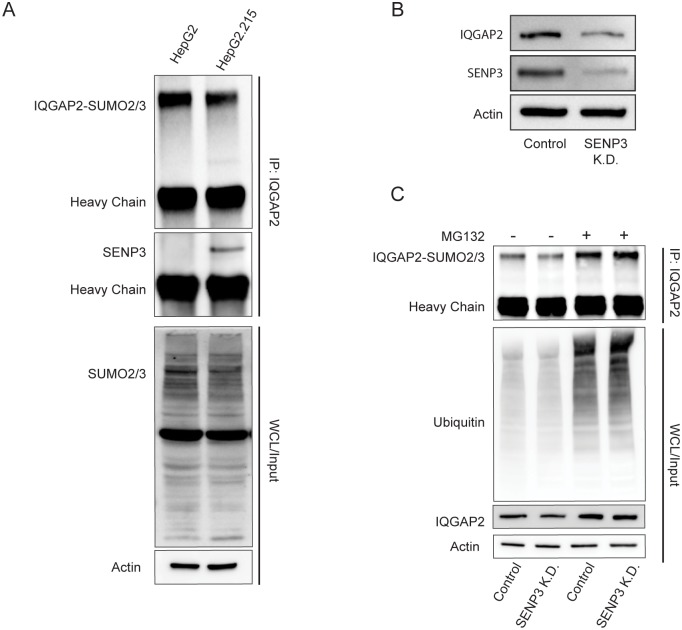
IQGAP2 is a de-SUMOylation target of SENP3.(A) Upper: immunoprecipitation (IP) with an anti-IQGAP2 antibody in HepG2 and HepG2.215 cells followed by immunoblotting of SUMO2/3 and SENP3; lower: immunoblotting of SUMO-2/3 in corresponding whole cell lysates (WCL). (B) Immunoblotting of IQGAP2 in HepG2.215 control and HepG2.215 SENP3 K.D. cells. (C) Upper: immunoprecipitation (IP) with an anti-IQGAP2 antibody followed by immunoblotting of SUMO-2/3 in HepG2.215 control and HepG2.215 SENP3 K.D. cells without MG132 treatment (1st and 2nd lanes), HepG2.215 control and HepG2.215 SENP3 K.D. cells treated with 1 μM MG132 for 6 hrs (3rd and 4th lanes); lower: immunoblotting of ubiquitin and IQGAP2 in corresponding whole cell lysates (WCL).